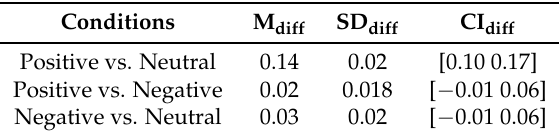
Figure A19. Paired two-sample bootstrap test of significance (10,000 simulation runs) at 95.0% CI associated with the participants’ PE6s (i.e., 62 PE6s associated with 62 EEG channels of a participant, per affect). Compared pairs of mental states are ( A ) positive versus neutral, ( B ) positive versus negative, and ( C ) negative versus neutral. X-axis: difference between average values of two affective states (e.g., positive versus negative). Blue line: non-significant difference between PE6s of two different affective states. Red lines: 95.0% confidence interval boundaries. Yellow line: average two affetective states’ mean differences over 10,000 simulations. Table A14. Paired two-sample bootstrap test of significance (10,000 simulation runs) at 95.0% confidence interval (CI) applied on the participants’ PE6s (i.e., 62 PE6s associated with 62 EEG channels of a participant, per affect). Compared pairs of mental states are: positive versus neutral, positive versus negative, and negative versus neutral. M: mean difference, SD: standard deviation of such a difference. CI: 95% confidence interval for every paired affective states’